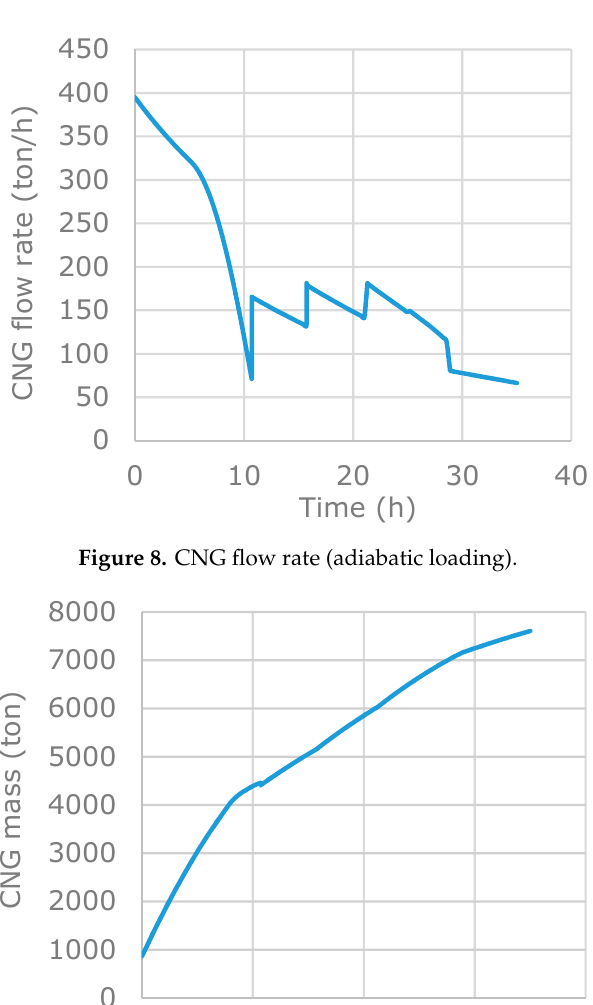
Figure 7. Pressure vessels CNG conditions (adiabatic loading).